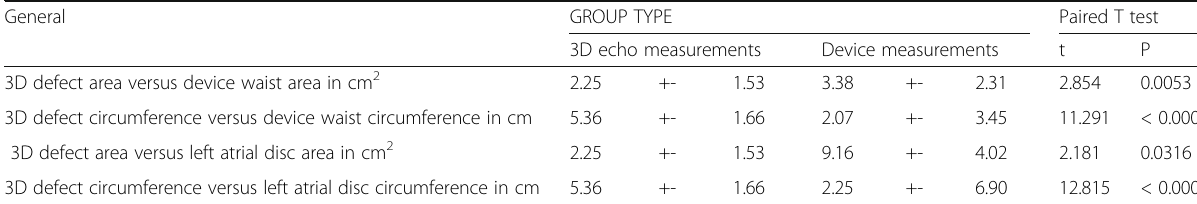
Table 4 univariate analysis of 3D echo guided defect area and circumfrence versus device parameters using independent sample T test General GROUP TYPE Paired T test 3D echo measurements Device measurements 3D defect area versus device waist area in cm 2 3D defect circumference versus device waist circumference in cm 3D defect area versus left atrial disc area in cm